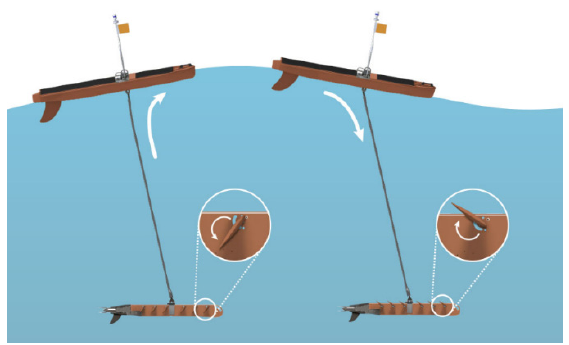
Figure 3. Working principle of the wave glider.